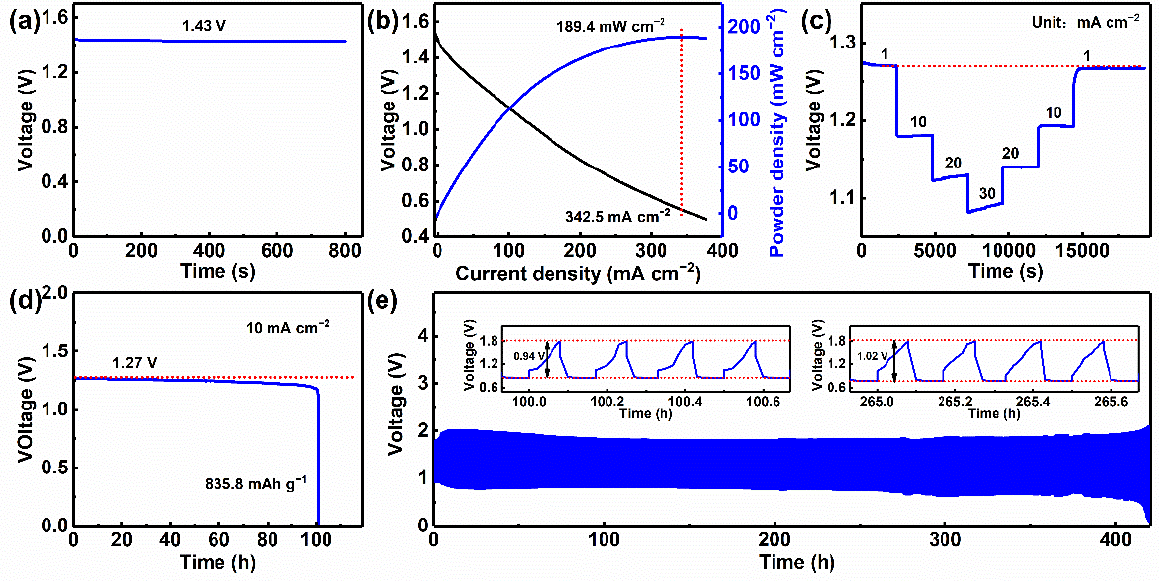
Figure 7. ( a ) Initial profile of open-circuit voltage, ( b ) discharge polarization curve and the power density profile, ( c ) rate performance from 1 to 30 mA cm − 2 , ( d ) continuous galvanostatic discharge curve at 10 mA cm − 2 , ( e ) galvanostatic discharge and charge cycling curve of Zn–air battery assem- bled with NPCNSs-1000 at 10 mA cm − 2 with each cycle for 20 min (discharge for 10 min and charge for 10 min).